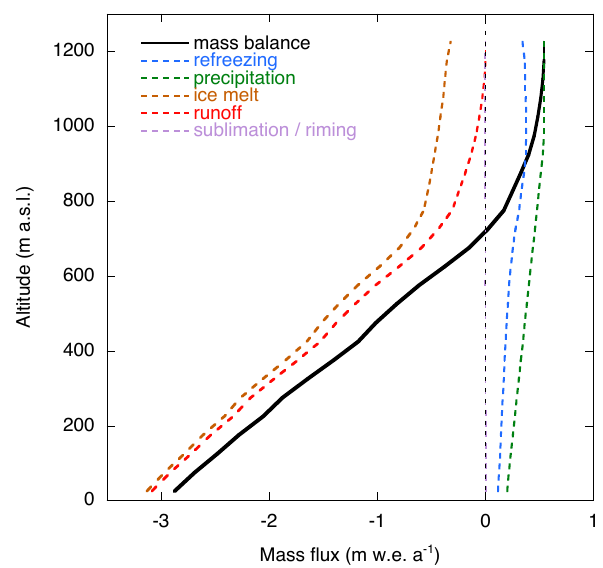
Fig. 5. Elevation profiles of the mass balance, refreezing, precipita- tion, ice melt, runoff and the mass flux by sublimation and riming. Data are divided into 25-m bins and averaged over the simulation period